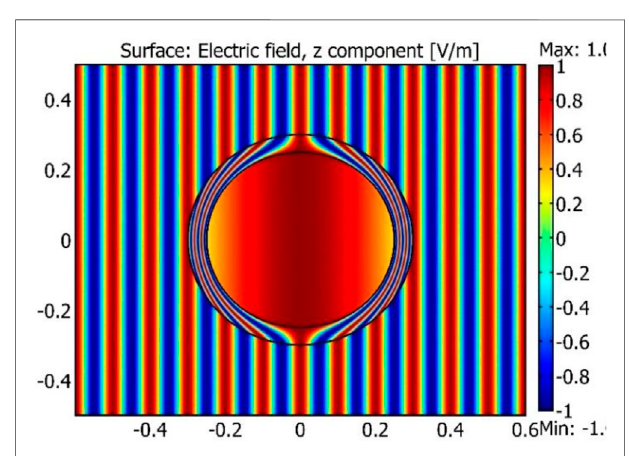
FIGURE 2 | fi eld distribution of a TE incident wave with working frequency 1GHZ, a (cid:2) 0 . 25 m , b (cid:2) 0 . 3 m and. c (cid:2) 0 . 02 m .